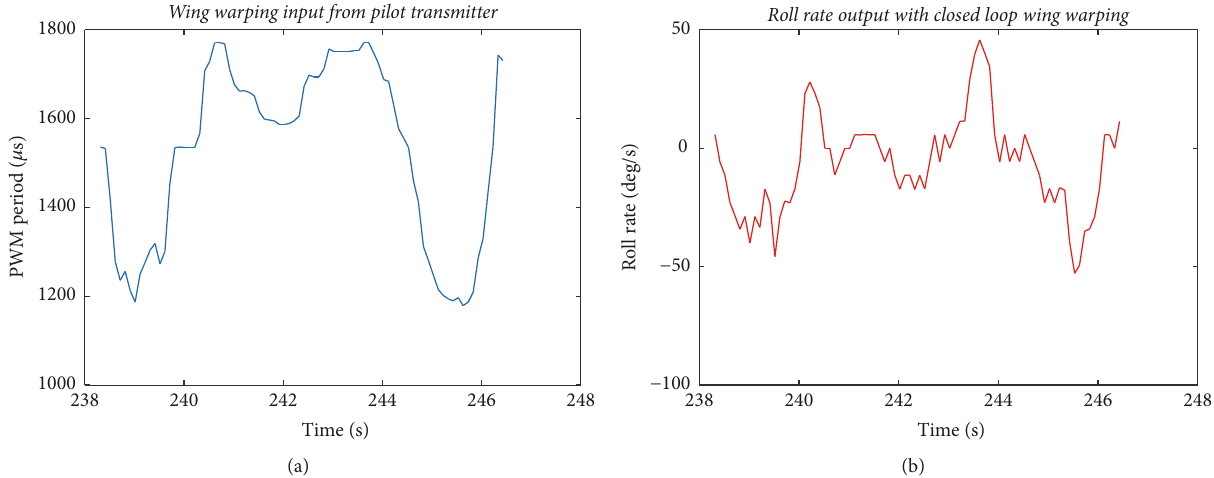
Figure 19: Roll rate of the FMW with closed-loop wing warping double: (a) rudder inputs from pilot; (b) roll rates of the FMW